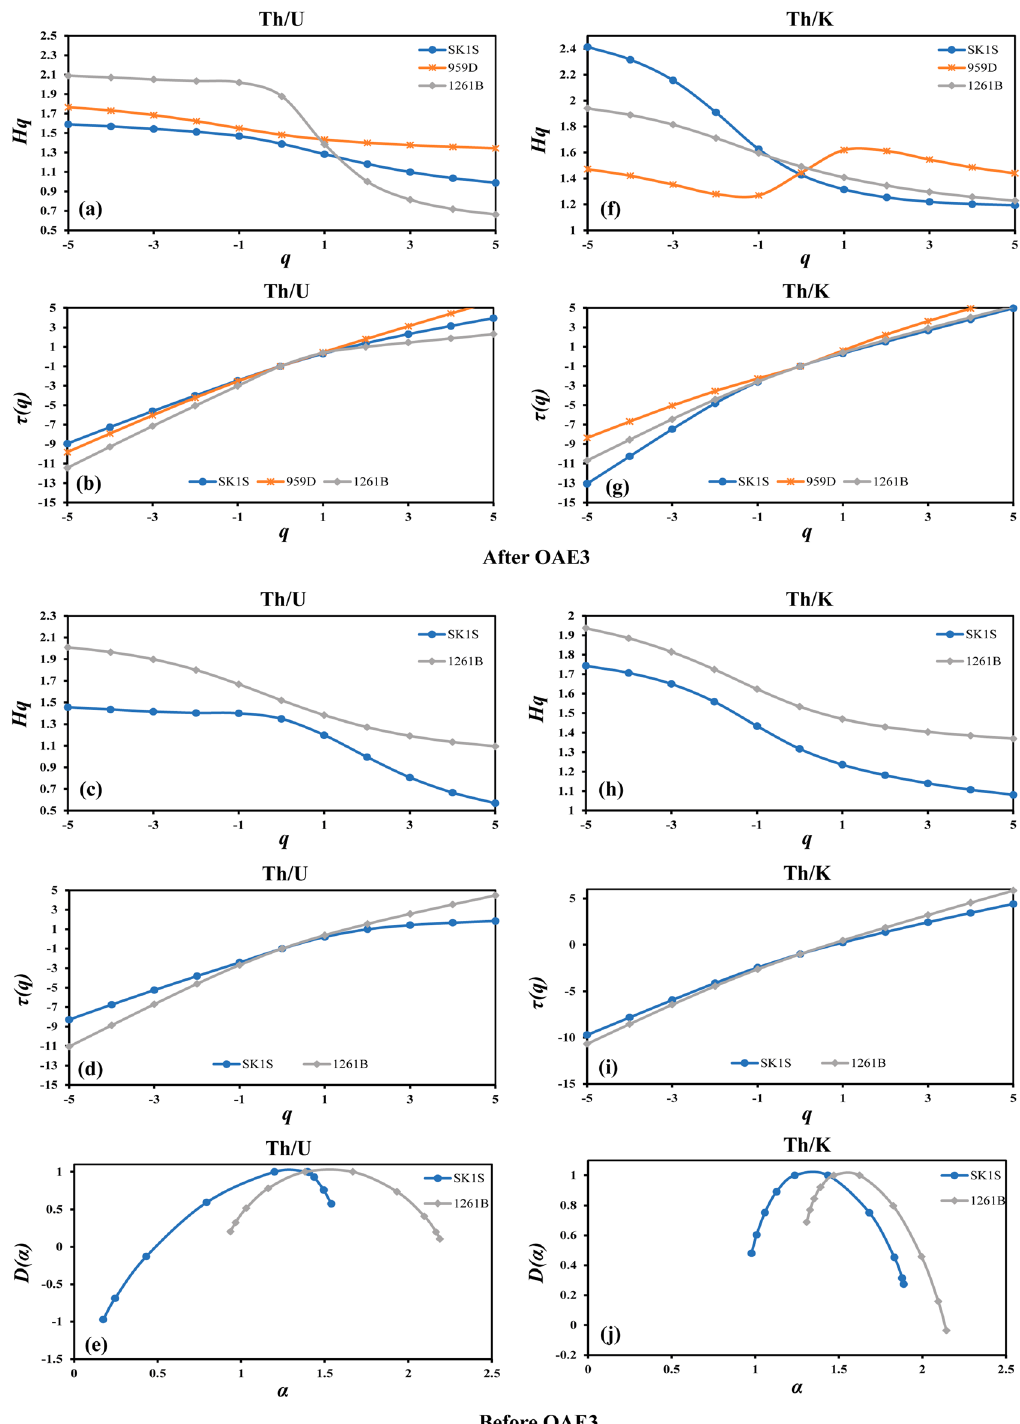
Figure 6. The Multifractal properties of the thorium–potassium and thorium–uranium distributions before and after the OAE3 intervals recorded in Songliao Basin (SK1S), Deep Ivorian Basin (959D) and Demerara Rise (1261B). Hq , the generalized Hurst exponents. τ(q) the mass exponents, D(α) the multifractal